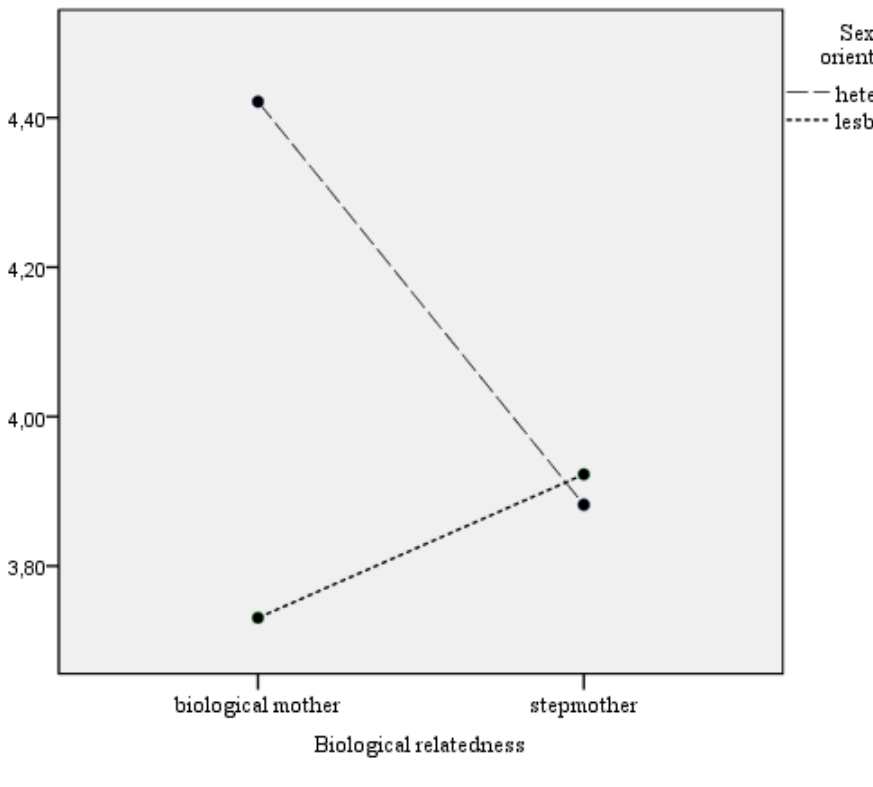
Figure 2. Ancova Interaction for Competence Evaluations.